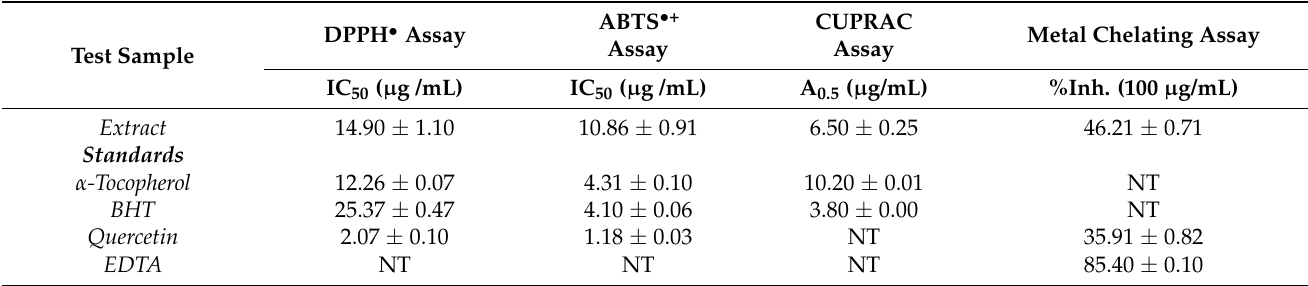
Table 3. Antioxidant activity of propolis